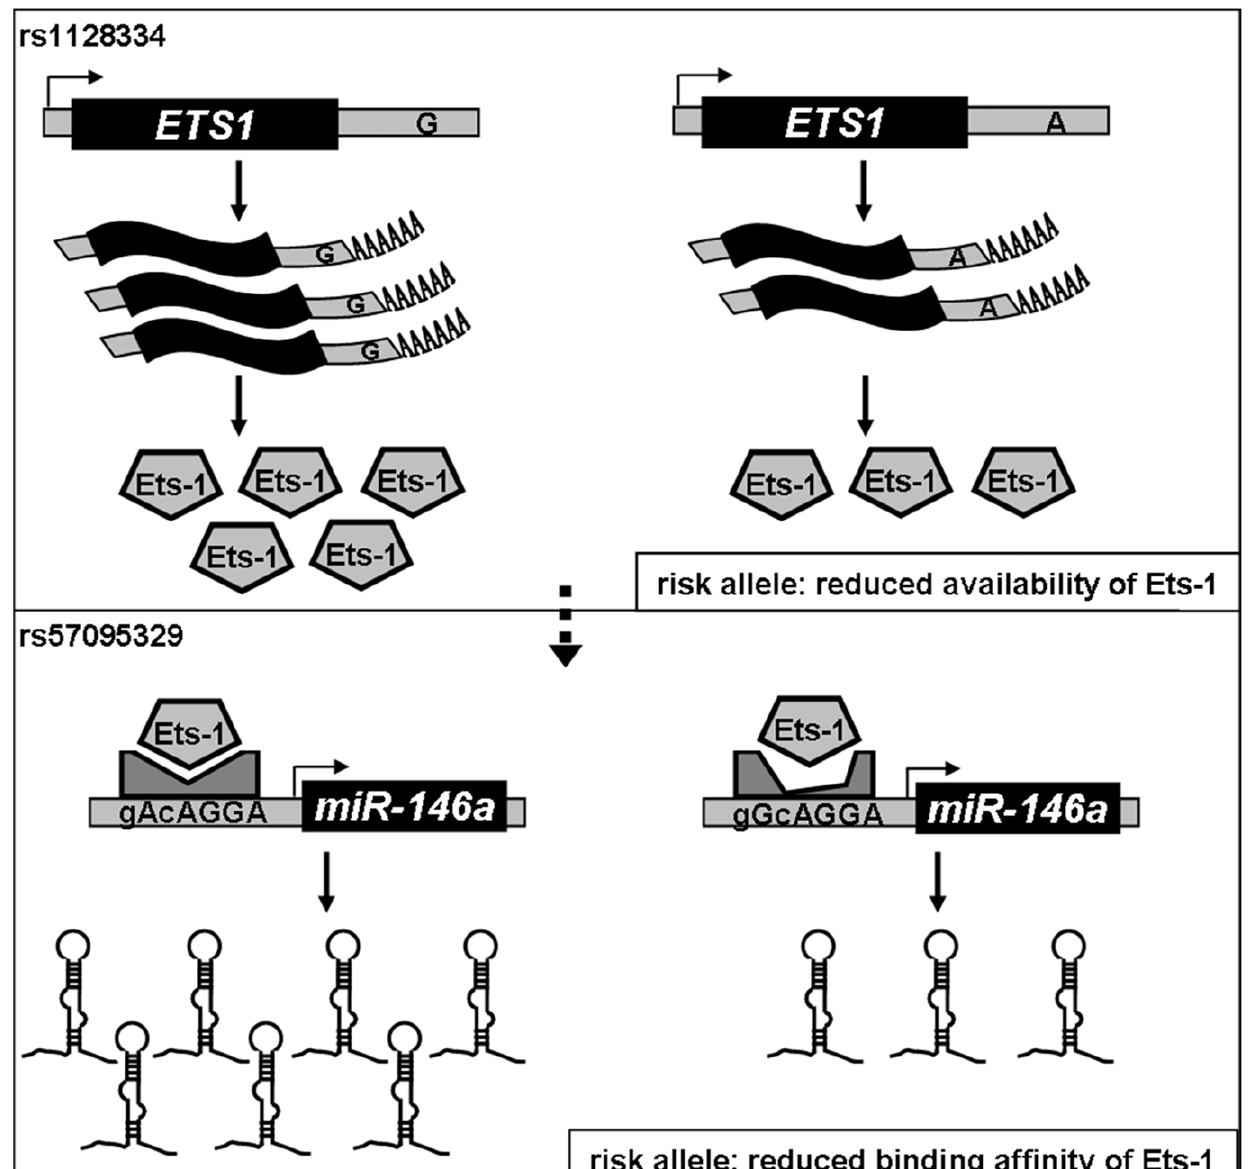
miR-146a expression. We previously found that the A allele of rs1128334 located in the ETS1 3 9 untranslated region is associated with SLE by reducing Ets-1 expression ( upper panel ). In this study, we show that the binding affinity for Ets-1 is affected by the risk-associated G allele of rs57095329, which causes an incompetent compositional change ( lower panel ), and therefore represents another genetic factor that contributes to the reduced expression of miR-146a in SLE